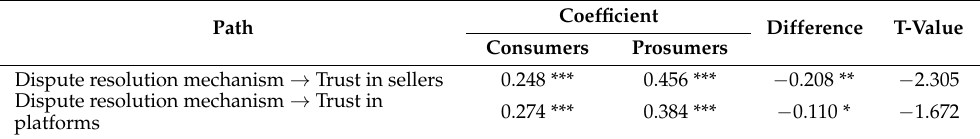
Table 5. Path coefficient comparison between consumers and prosumers.